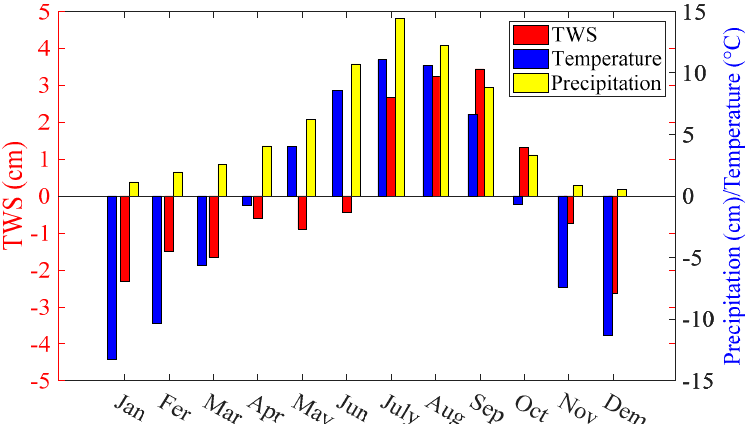
Figure 10. Annual distributions of water storage variations in terms of the equivalent water thickness (cm), temperature (°C), and precipitation (cm) on the Tibetan Plateau by means of monthly averages over the period from August 2002 to December 2016.